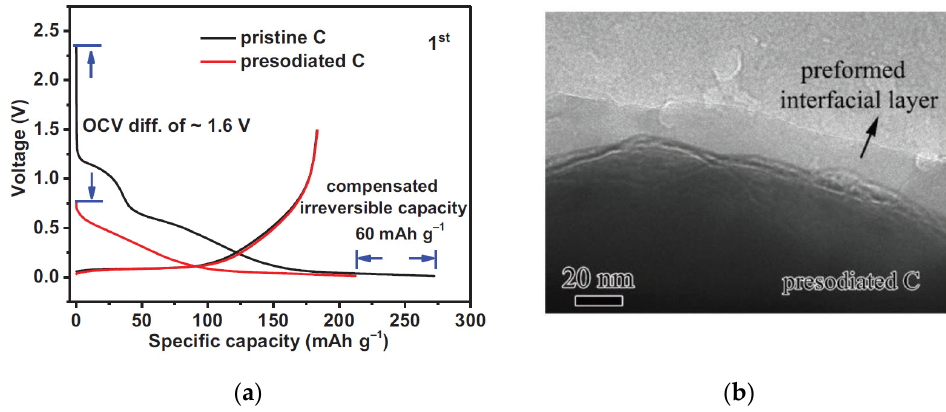
Figure 7. Electrochemical performances of the carbon electrodes with and without presodiation. ( a ) The voltage-capacity curves of the pristine and presodiated carbon electrode for the first charge/discharge cycle. ( b ) TEM images of presodiated carbon after immersed in a liquid electrolyte before battery cycling. (Reprinted with permission from [107]. Copyright 2019, Wiley Online Library).